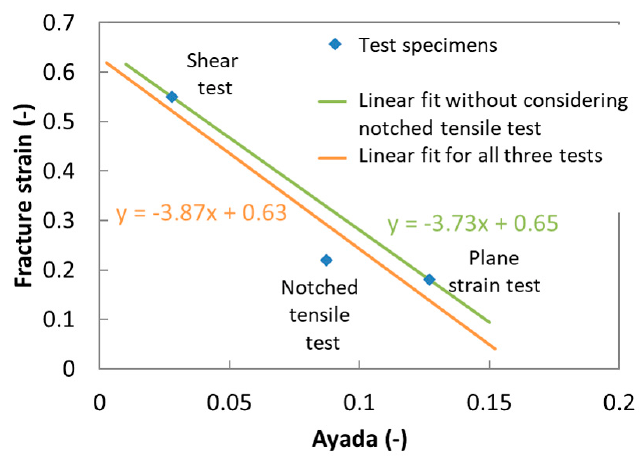
(cid:82) ε σ f m σ d ε and ε f 0 eq (cid:1856)(cid:2013) (cid:3084) (cid:3281) and (cid:2013) (cid:3033) . (cid:2868) (cid:3097) (cid:3280)(cid:3292)